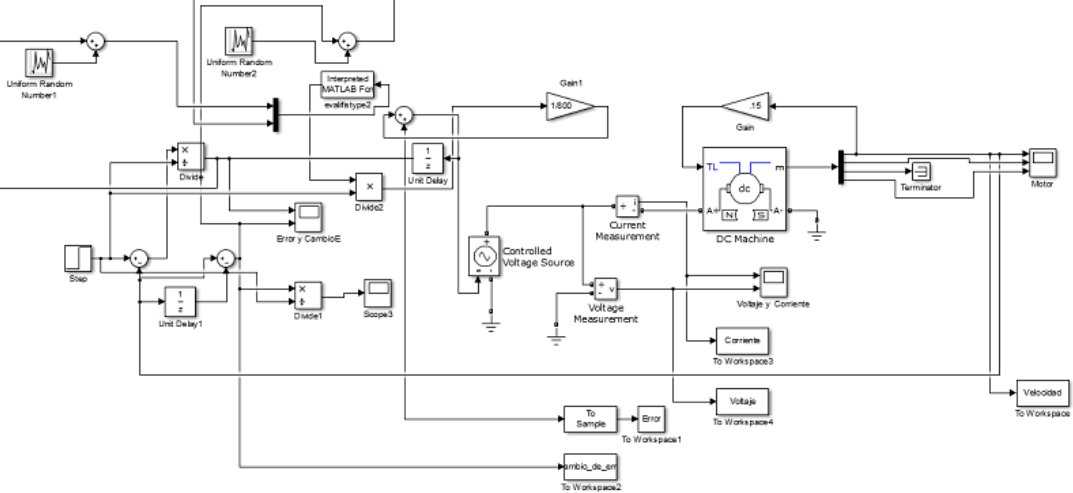
Figure 8. Graphical illustration of the noise affecting the